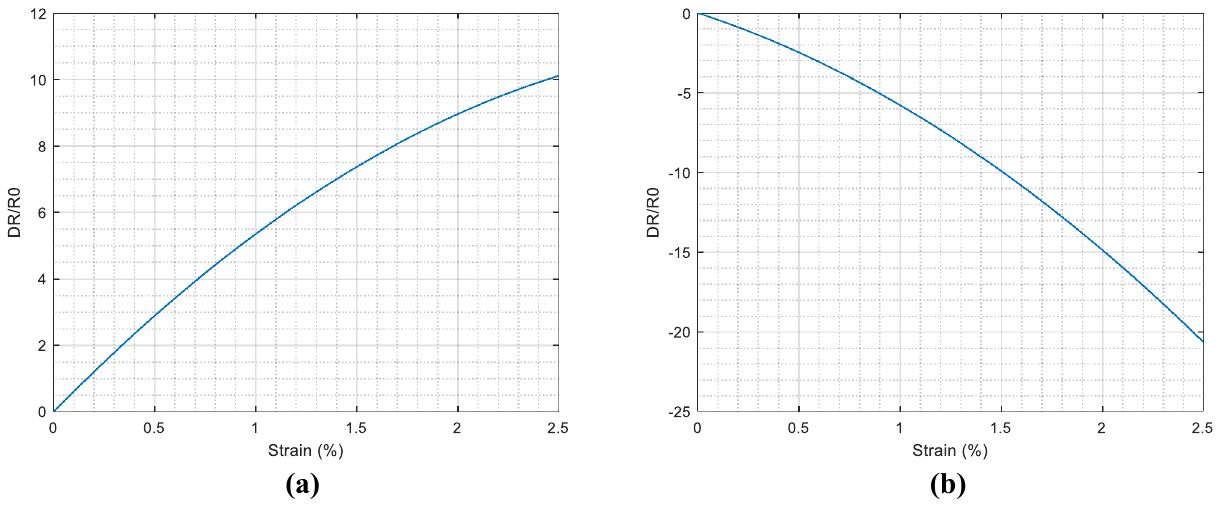
Fig. 7 DR/R0 in the function of strain obtained from the modelling for a graphene-based strain sensing element under tensile load a and compression loading